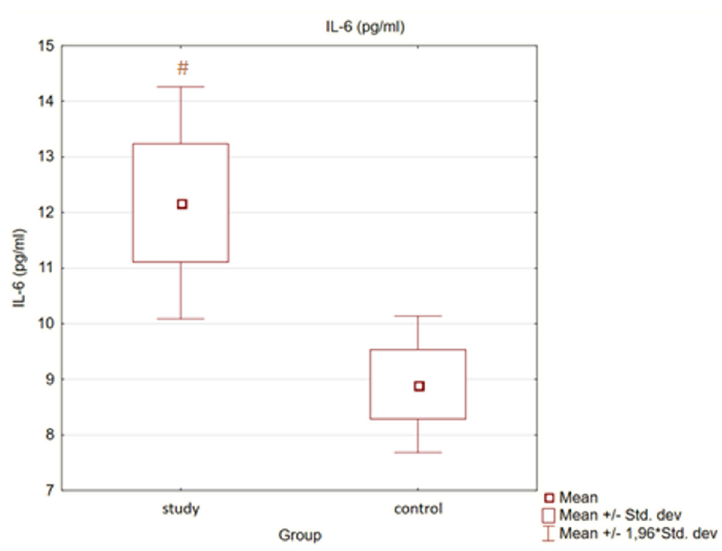
Figure 1. Concentration of interleukin 18 (Il-18) in study and control group (#— p < 0.05 versus control).